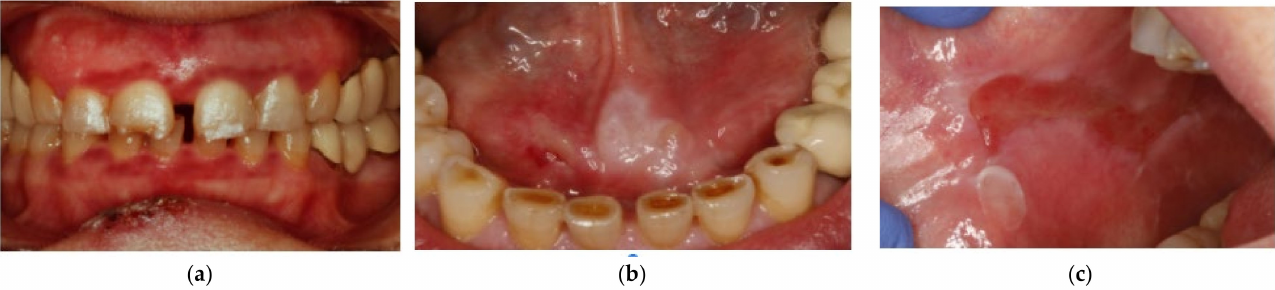
Figure 1. Initial state of the patient before starting treatment. The patient presented oral lesions localized in the ( a ) gingiva; ( b ) the floor of the mouth; ( c ) the right buccal